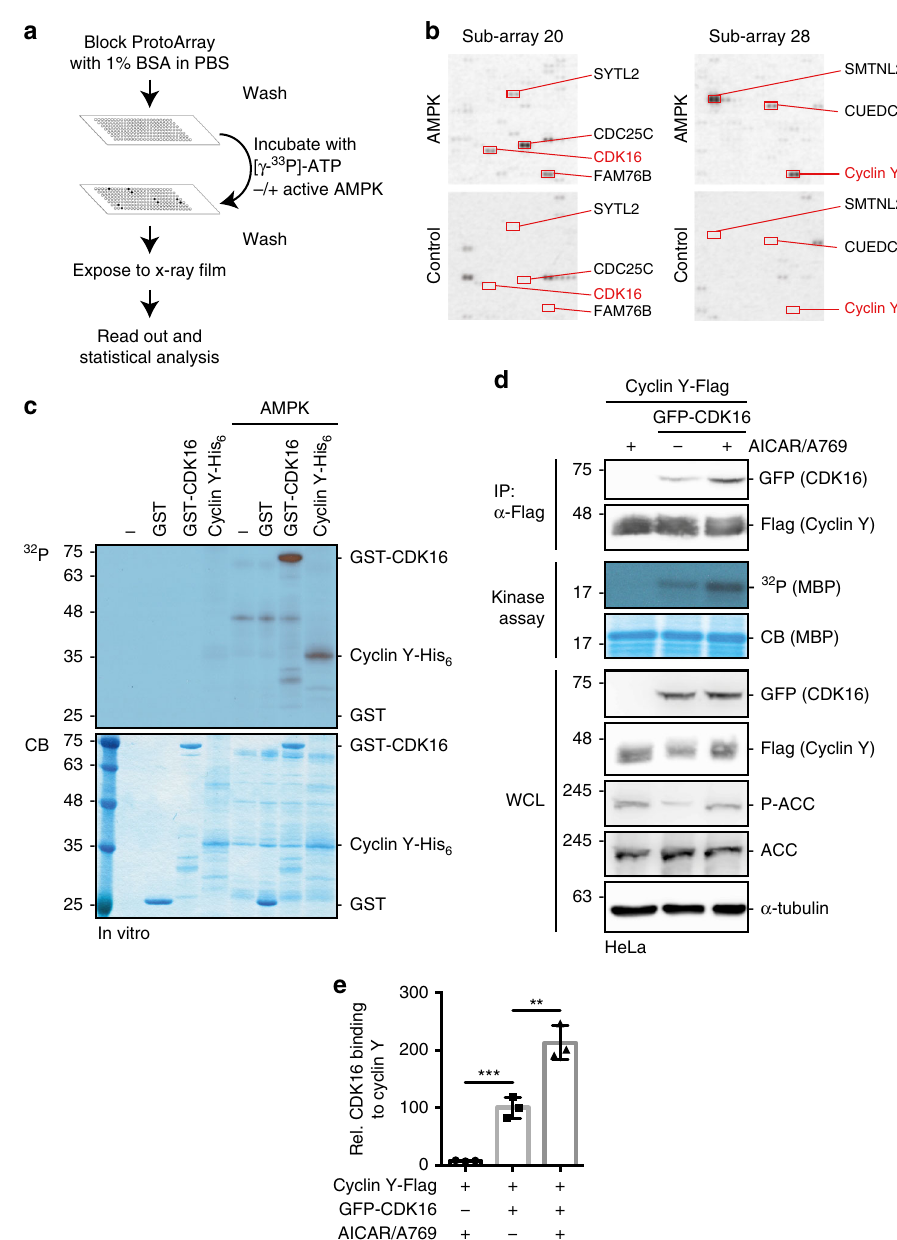
Fig. 1 Protein microarray screen for the identi fi cation of AMPK substrates. a Schematic representation of the ProtoArray based screen with approximately 9000 human proteins using AMPK (see also Supplementary Data 1). b Details of two sub-arrays incubated with or without AMPK with marked substrates are shown. c GST-CDK16, Cyclin Y-His 6 and GST were incubated in the presence of [ γ - 32 P]-ATP with AMPK. Phosphorylation was determined by autoradiography ( 32 P, top). Proteins were visualized by Coomassie blue staining (CB, bottom; n = 2). d HeLa cells were transfected with vectors expressing GFP-CDK16 and Cyclin Y-Flag and treated for 1 h with 0.5 mM AICAR/50 µ M A769662 (A769) as indicated. Cyclin Y-Flag was immunoprecipitated with Flag antibodies (IP) and immunoblotted against CDK16 and Cyclin Y or used for in vitro kinase assays with myeloid basic protein (MBP) as substrate. Autoradiographs ( 32 P) and Coomassie blue staining (CB) of MBP are displayed. Whole cell lysates (WCL) were immunoblotted with the indicated antibodies ( n = 3). e Quanti fi cation of CDK16 co-immunoprecipitated with Cyclin Y. Statistical signi fi cance was measured via unpaired and two-tailed Student ’ s t -tests and is presented as follows: ** p < 0.01, and *** p < 0.001. All error bars indicate SD ( n = 3; Cyclin Y + AICAR/A769 vs. Cyclin Y/CDK16: t = 8.719, df = 4; Cyclin Y/CDK16 vs. Cyclin Y/CDK16 + AICAR/A769: t = 5.595, df = 4). n biological independent replicate. SD standard deviation. Source data are provided as a Source Data fi